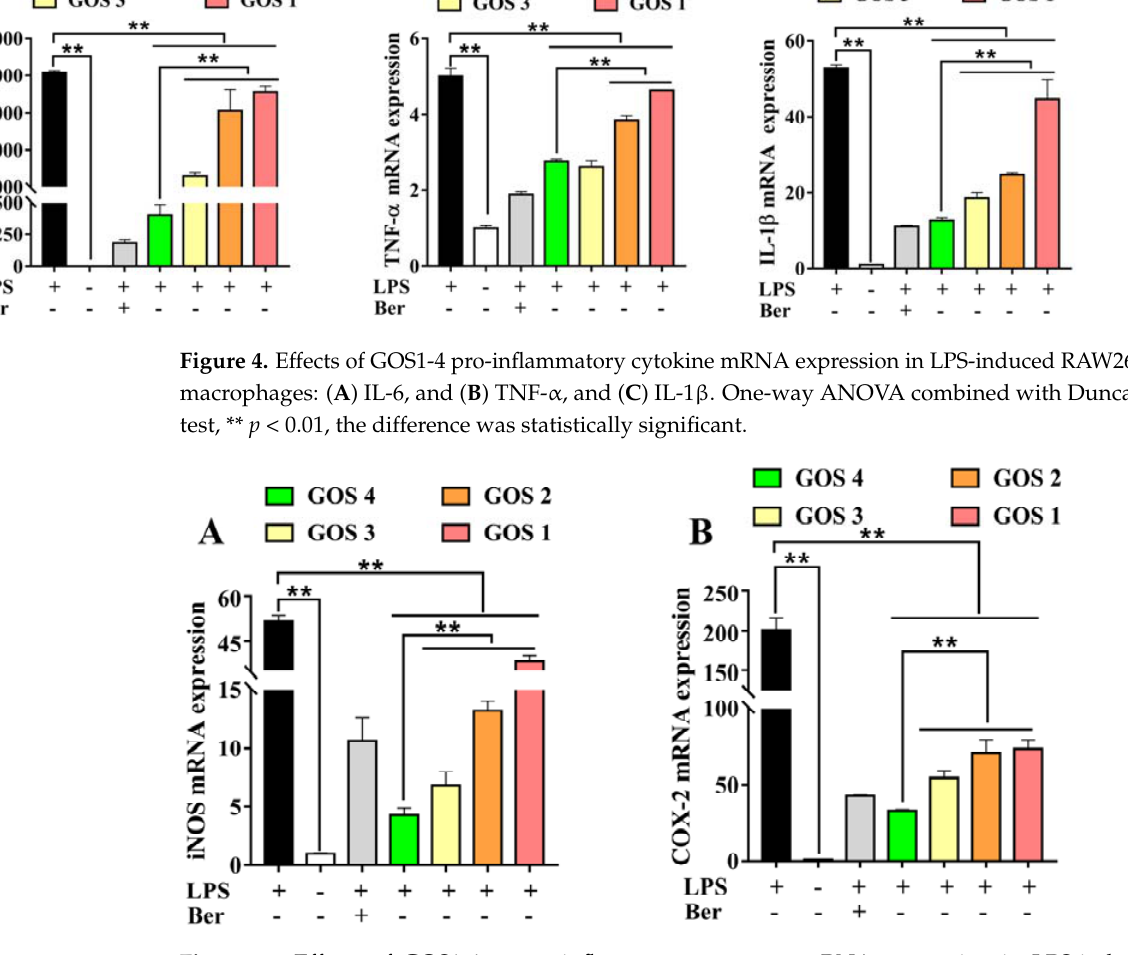
Figure 5. Effects of GOS1-4 on proinflammatory enzyme mRNA expression in LPS-induced RAW264.7 macrophages: ( A ) iNOS, and ( B ) COX-2. One-way ANOVA combined with Duncan’s test, ** p < 0.01, the difference was statistically